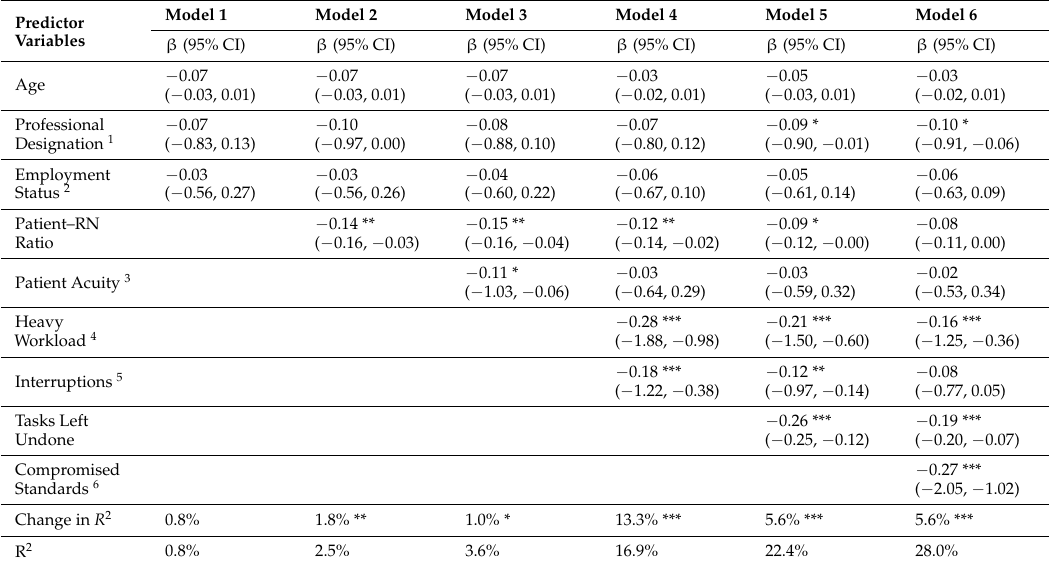
Table 6. Results of hierarchical multiple regression analyses for job satisfaction among nursing